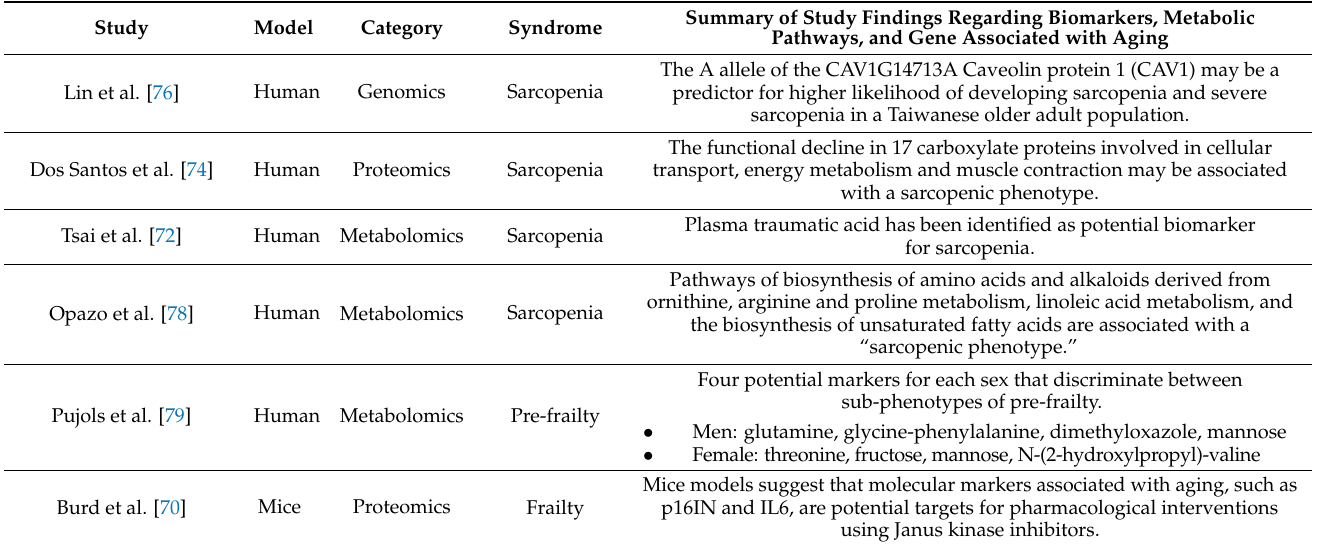
Table 2. Multi-OMICS in sarcopenia and